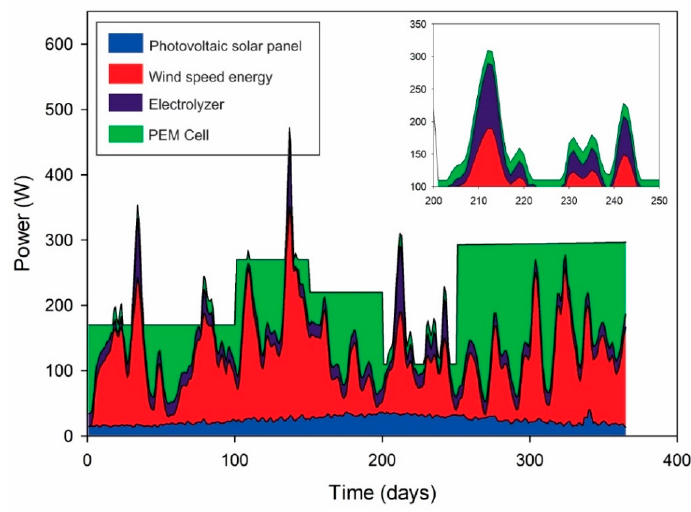
Figure 11. Power in Beijing (China).